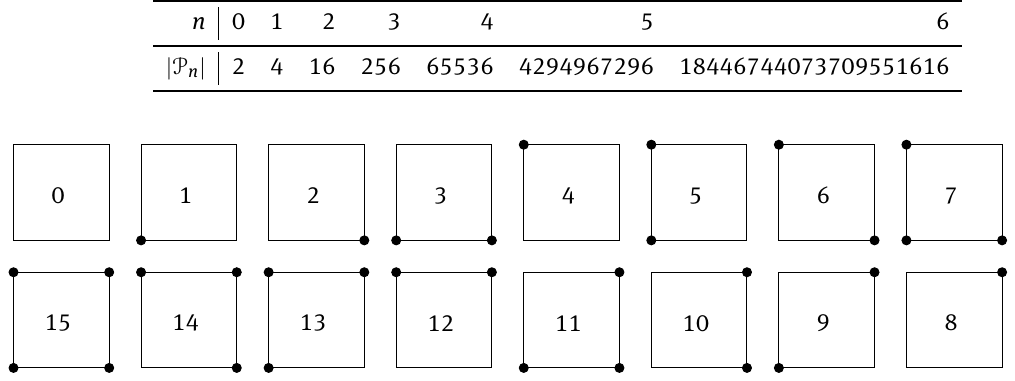
Figure 8: The sixteen 0/1 -polytopes in I 2 and their numbering given in (24).